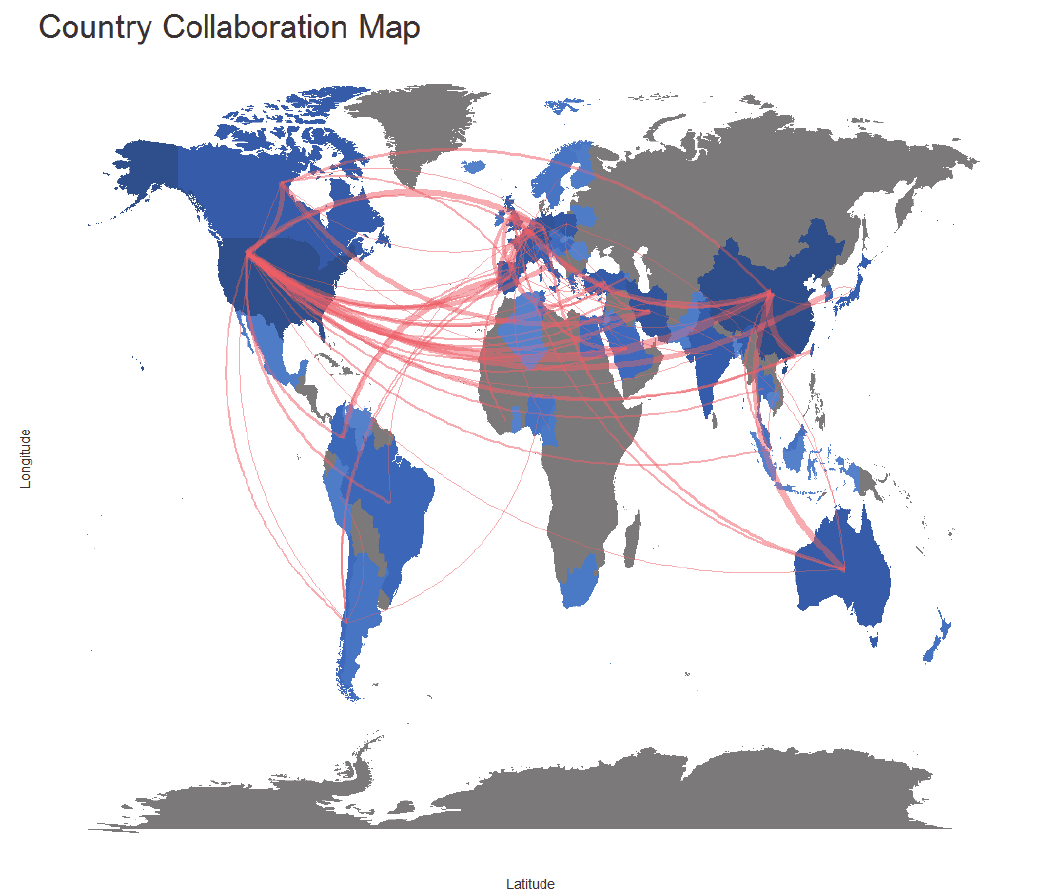
Fig. 3. Country collaboration